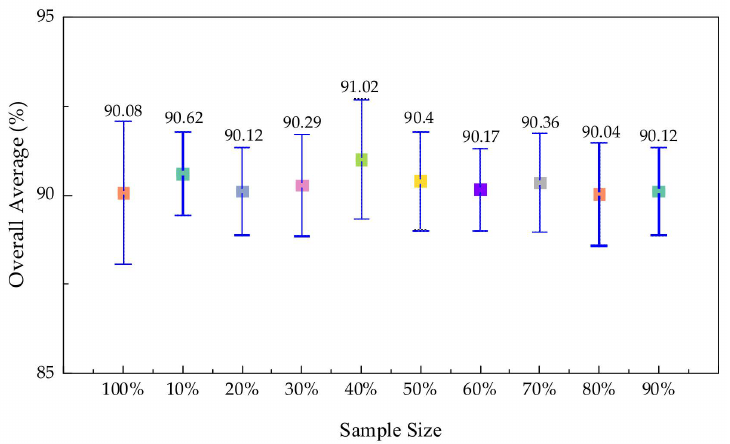
Figure 9. The overall accuracies and confidence intervals of SVM classifier after NKMNF with different proportion sample sizes (number of features = 45) in